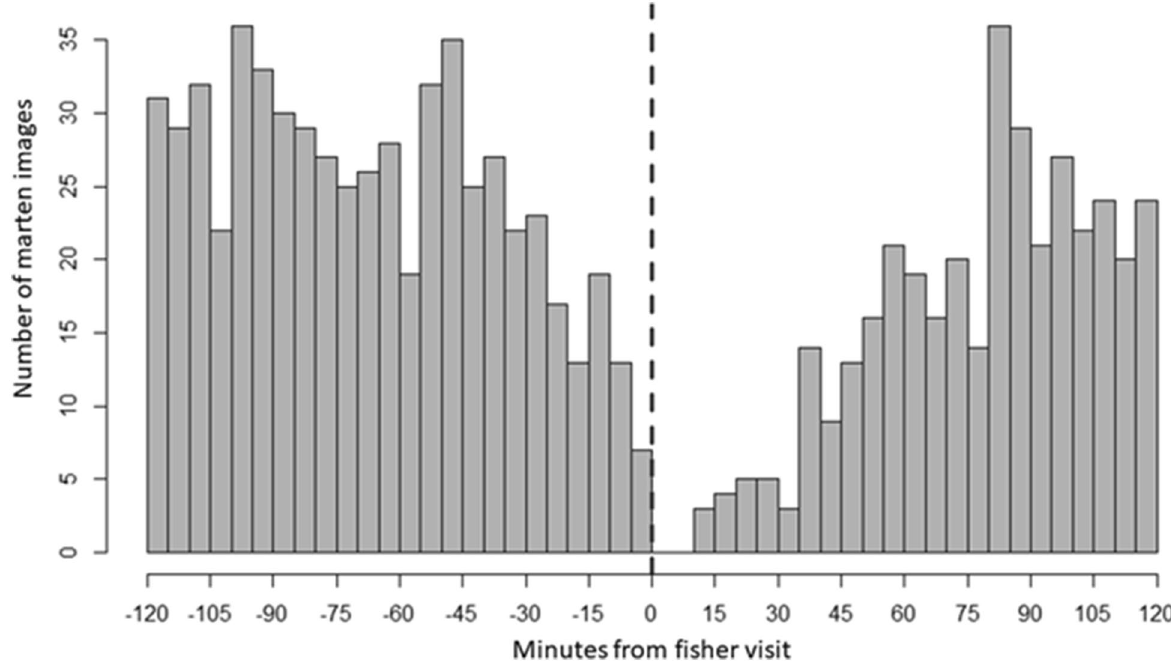
Figure 2. Histogram of American marten images recorded by remote cameras at scavenging sites within 2 h before (left of vertical dashed line) and after (right of vertical dashed line) fisher presence (vertical dashed line), Upper Peninsula of Michigan, USA, January–March